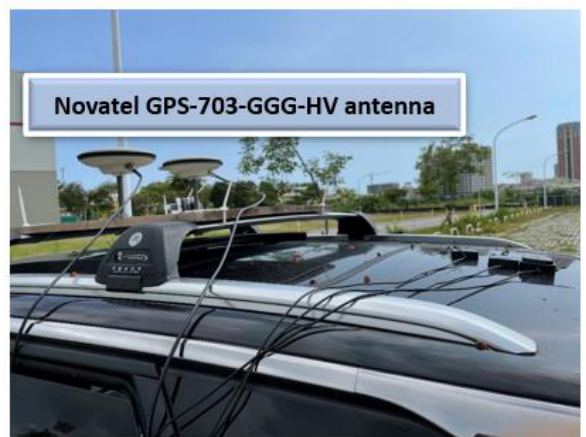
Figure 12 .Device above the car